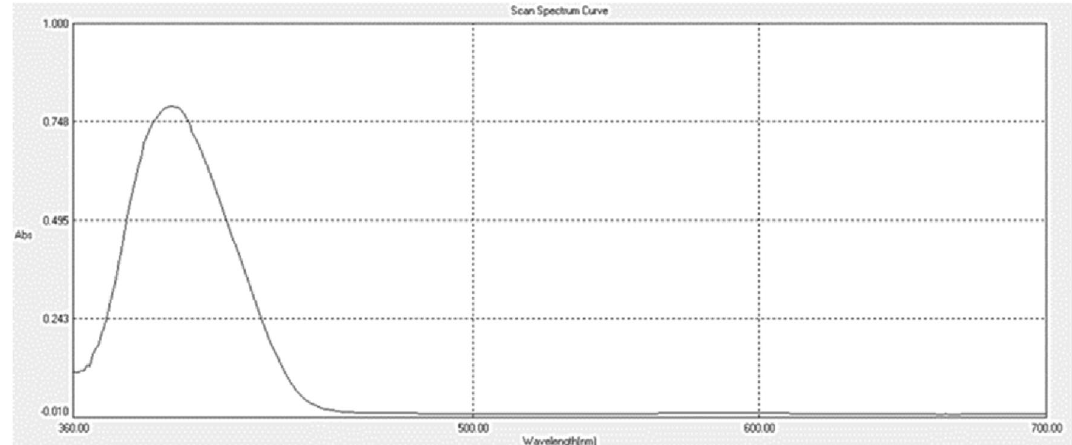
Figure 2. Absorption spectrum of the derivative product against a reagent blank (20 µg/mL